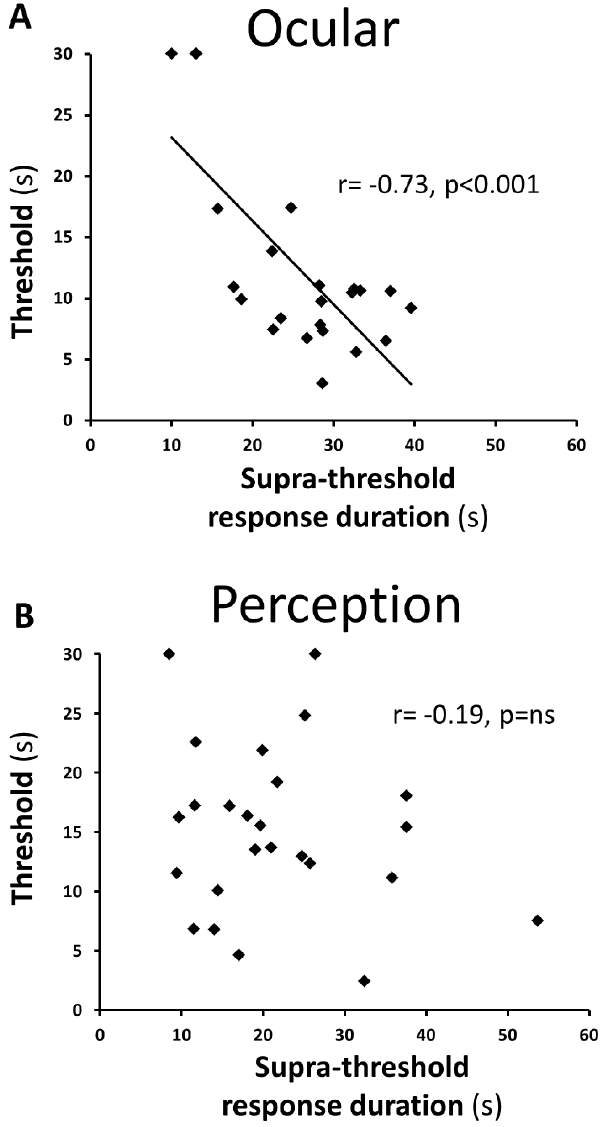
Figure 6. Scatter plots showing correlation between VO/VP threshold and supra-threshold responses. Correlation plots between duration of the response to the supra-threshold stimulus (90 u /s velocity step, x axis) and vestibular thresholds (y axis) for the vestibulo-ocular (A) and vestibulo-perceptual systems (B). The plots show good correlation between the two vestibulo-ocular results but absence of correlation between the perceptual results.